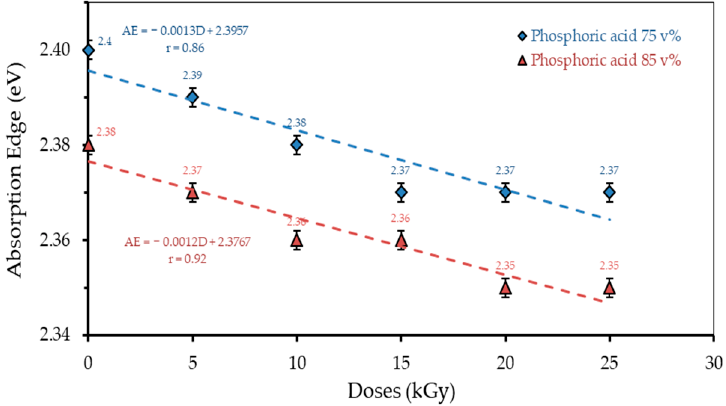
Figure 5. The relationship of the absorption edge with different radiation doses and H 3 PO 4 concentrations.